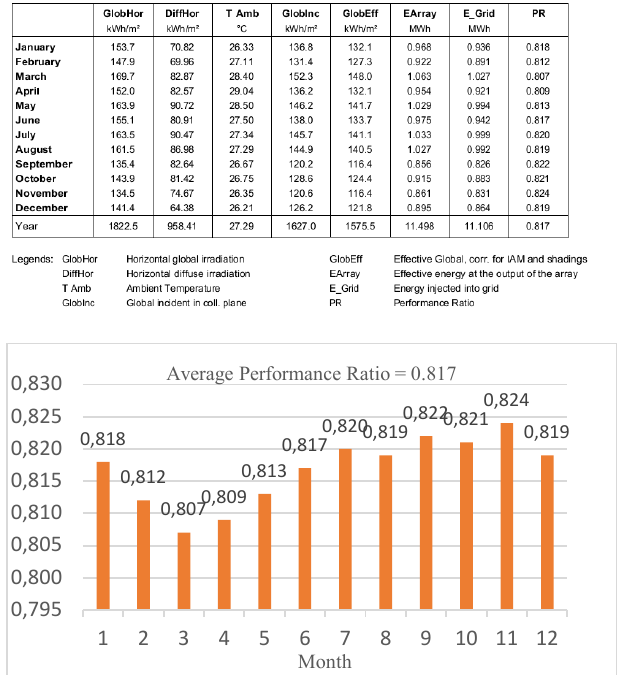
Table 4. The weather of the proposed location and monthly energy production